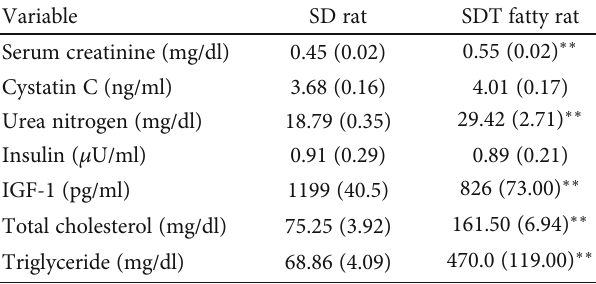
Table 2: Serum parameters at 24 weeks of